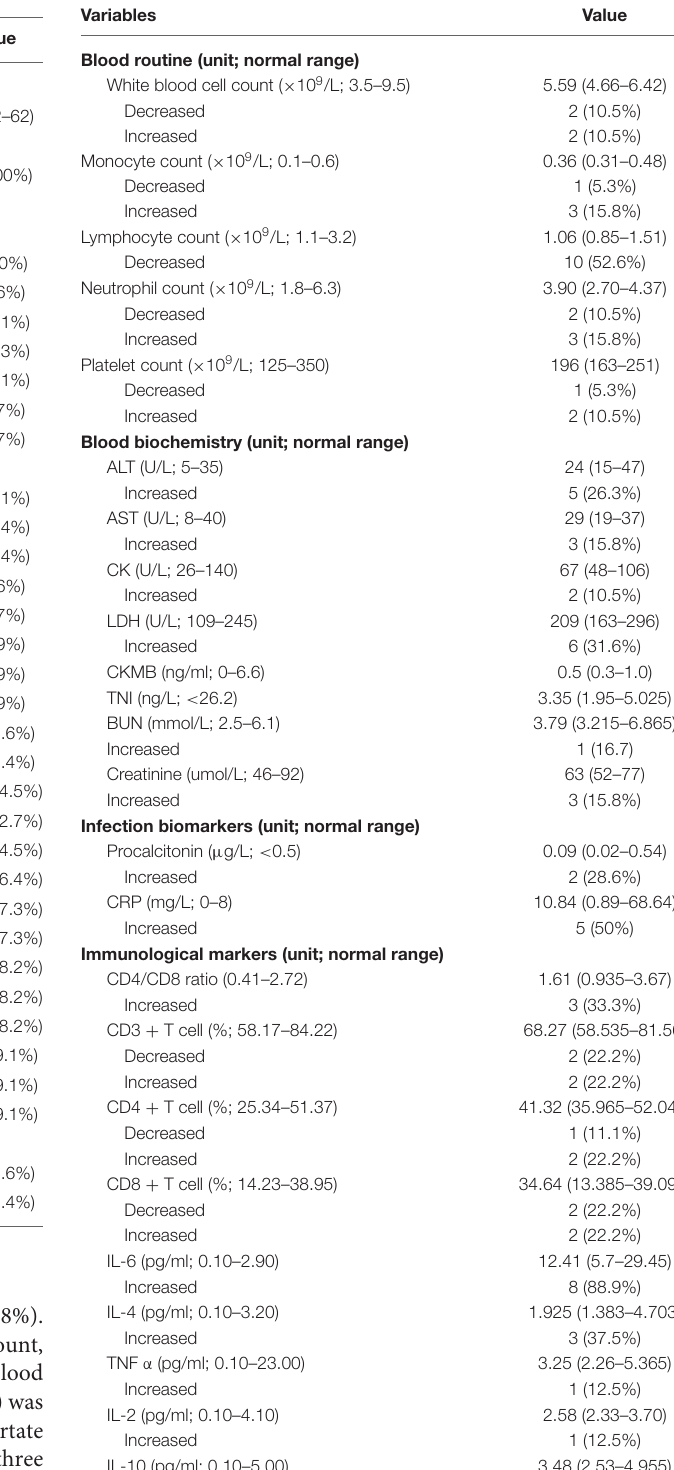
TABLE 2 | Laboratory findings of breast cancer patients with